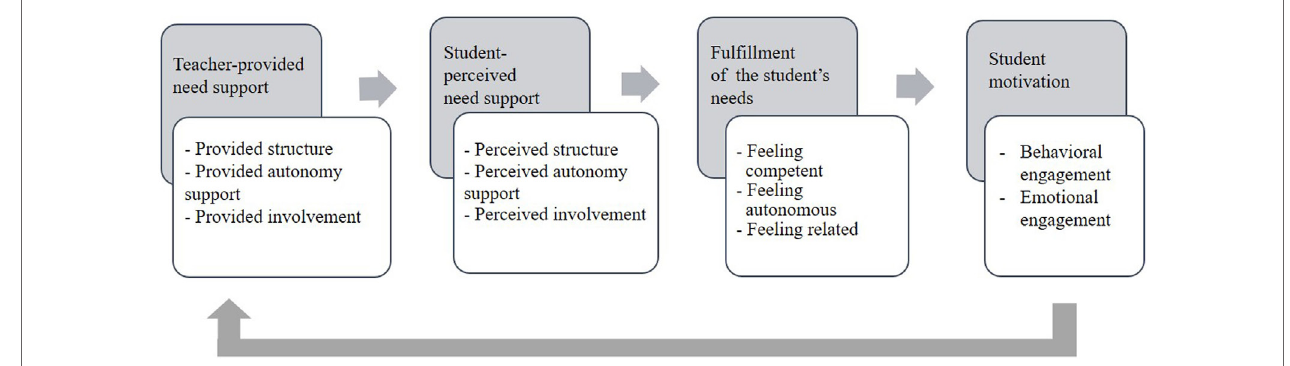
FigUre 1 | Theoretical model. Note: adapted from (Appleton et al., 2008).